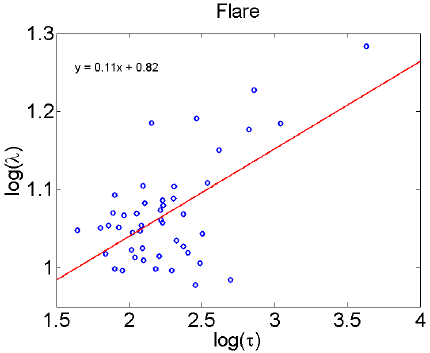
Figure 7. Length scale vs. timescale for all POD ranks; solar